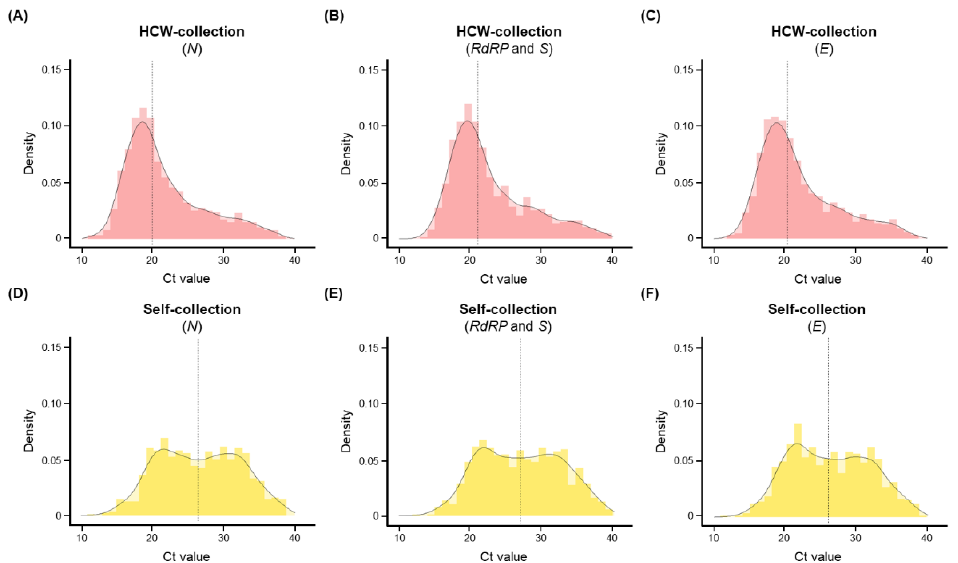
Figure 2. Histograms showing the distribution of Ct values for concordant positive specimens ( n = 850). ( A – C ) Density of ( A ) N , ( B ) RdRP and S , and ( C ) E in the HCW-collection group. ( D – F ) Density of ( D ) N , ( E ) RdRP and S , and ( F ) E in the self-collection group. The y-axis of the histograms represents the estimation of the probability density estimation, whereas the vertical line presents the mean values.